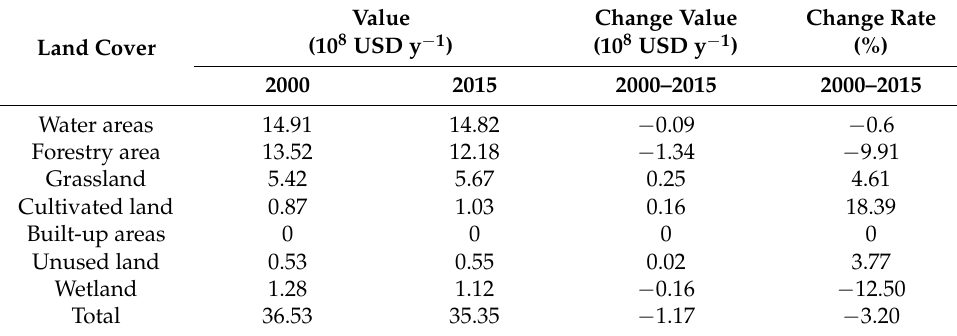
Table 7. The ESVs of 11 LULC types in 2000 and